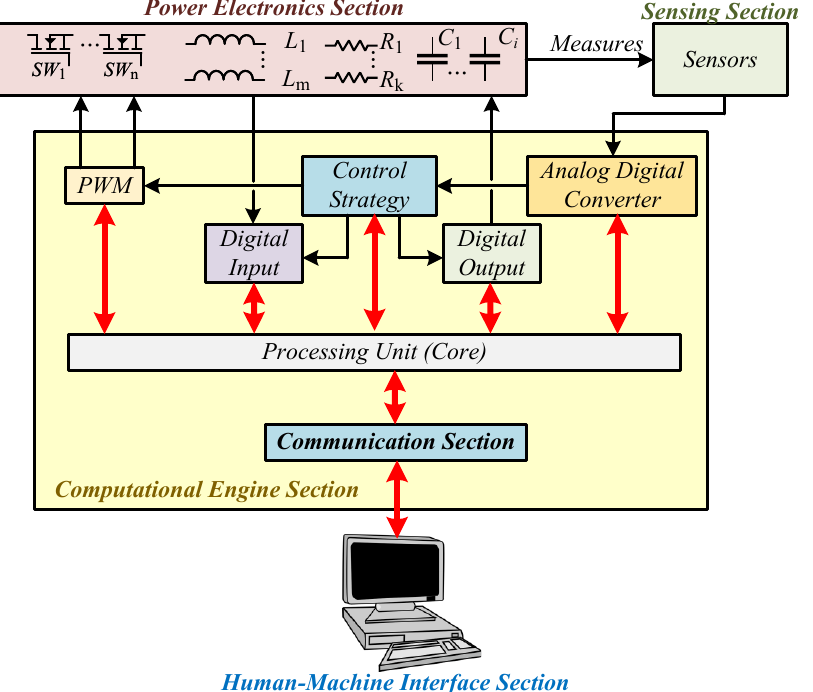
Figure 1. Typical architecture of an RTCP for DC/AC SPC